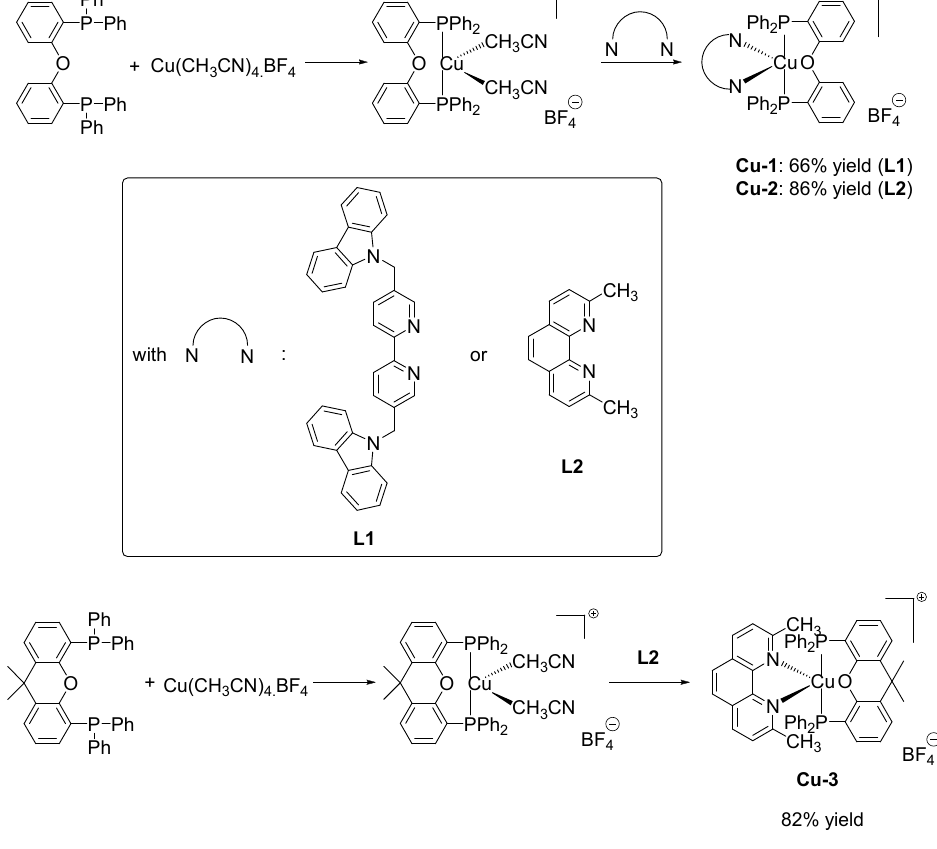
Scheme 1. Synthetic route to Cu-1 – Cu3 .